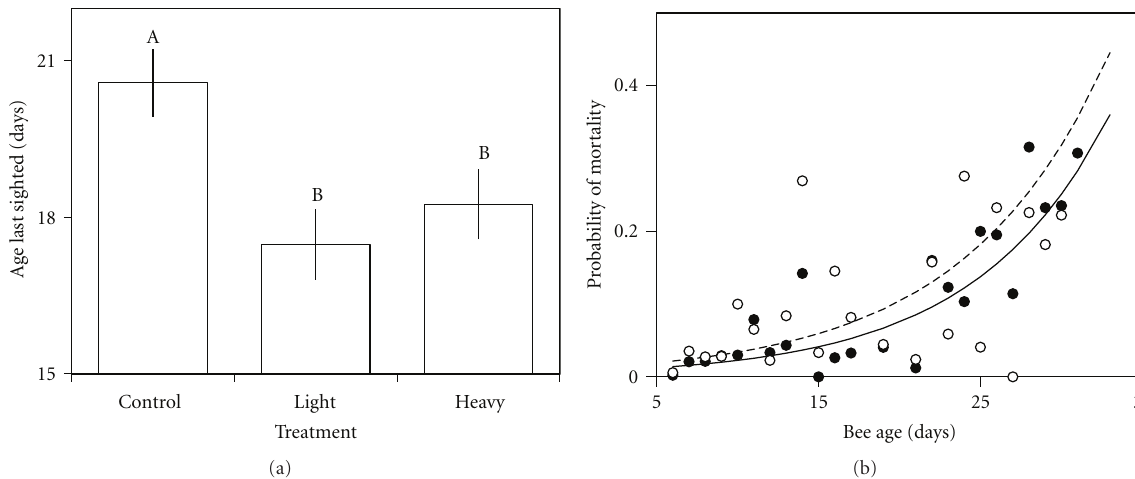
Figure 2: (a) Mean ( ± 1SE) lifespan of workers in the treatment groups. Bars that share the same letter did not significantly di ff er. (b) Hazard rate (probability of death per day) against bee age for Control (closed circles, solid line) and Light treatments (open circles, dashed line). The lines represent exponential fits of the data (0.0068 e 0 . 1 t , 0.0148 e 0 . 0861 t , respectively). Only two groups are shown for the sake of clarity and the curve for the Heavy group did not di ff er significantly from that for the Light group.